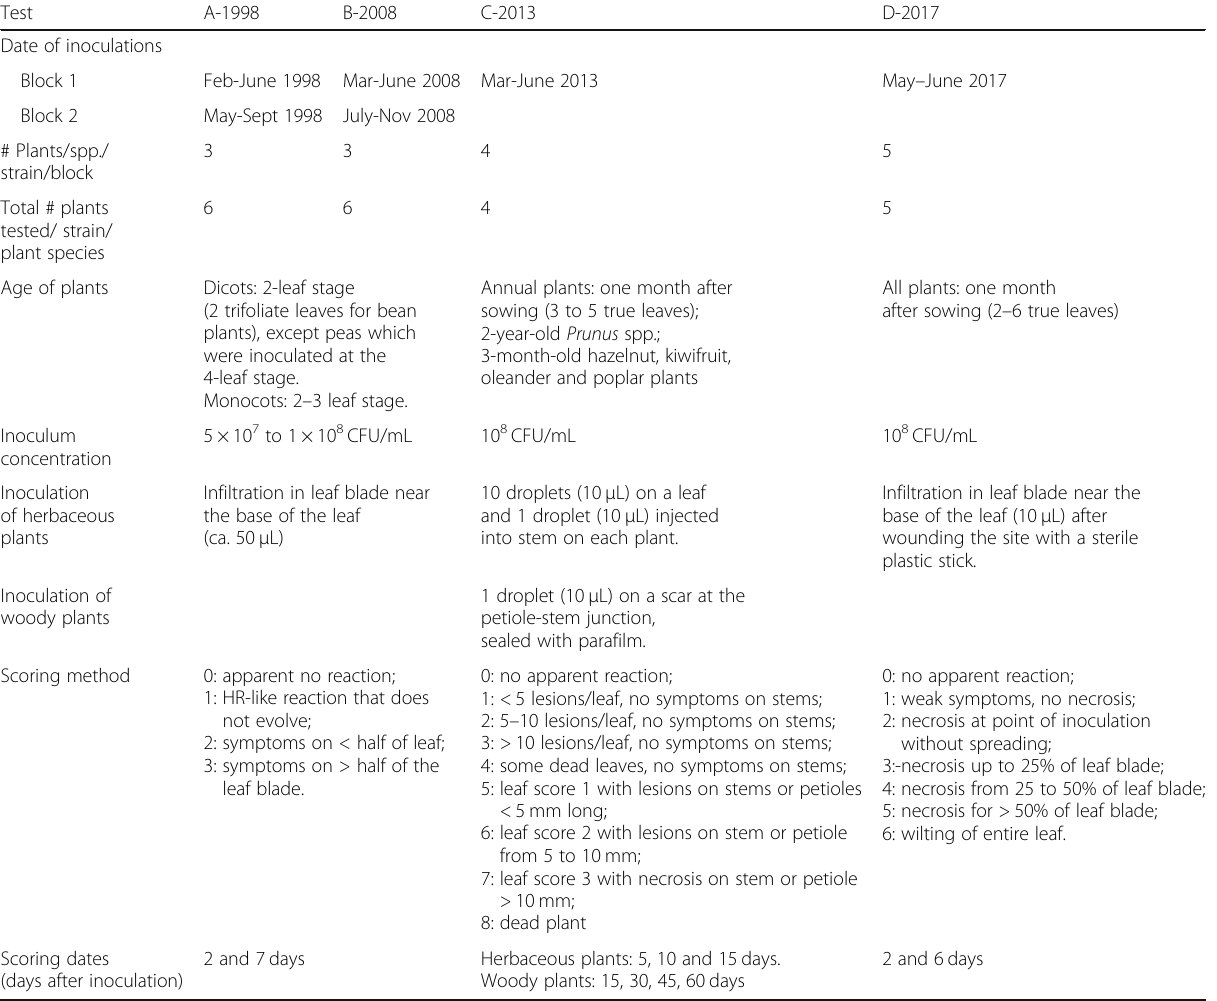
Table 6 Inoculation and incubation conditions and disease scoring scales used in the four tests of this